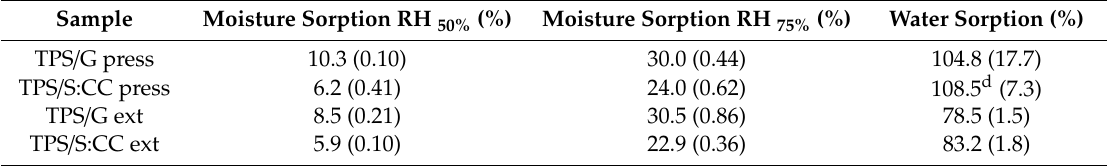
Table 6. Moisture sorption and swelling in distilled water of TPS / G and TPS / S:CC 2:1